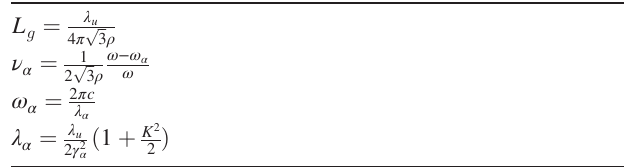
length, ν α ð α ¼ 1 ; 2 Þ a quantity related to the detuning parameter ν ¼ 2 π N ω 0 − ω , ω α the resonant frequency (and therefore λ α the ω 0 is the undulator period, ρ corresponding resonant wavelength), λ u the Pierce parameter, and γ the electron relativistic